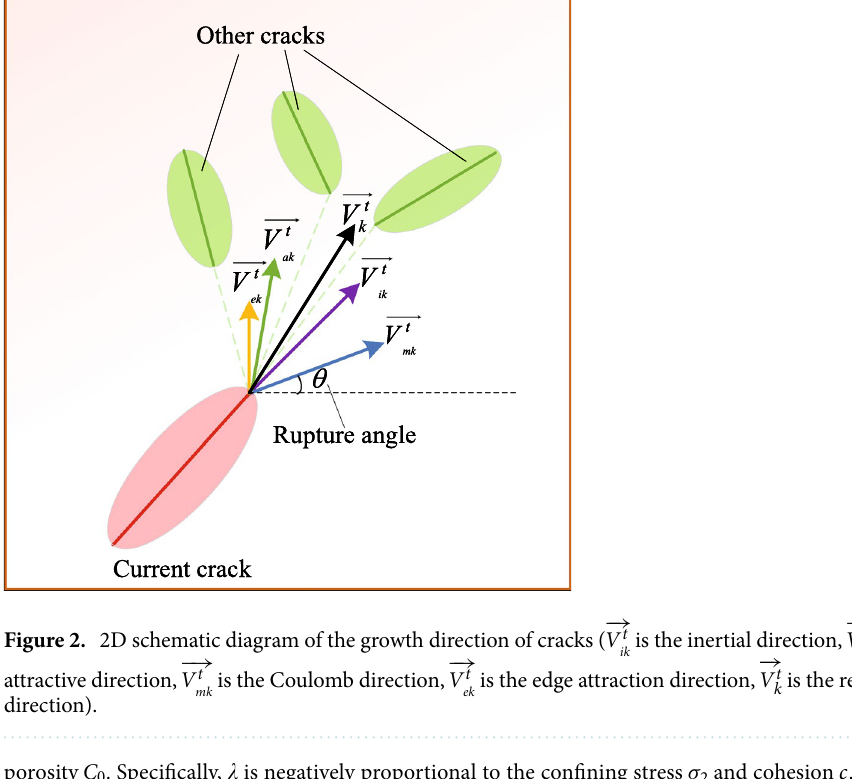
porosity C 0 . Specifically, (cid:31) is negatively proportional to the confining stress σ 2 and cohesion c . In other words, larger confining stress will lead to slower crack propagation, which accords with the laws of Eq. (10), indicat- ing that larger confining stress prolongs the time to reach the peak stress. Similarly, the cohesion c of the rock reveals the same pattern. Furthermore, increasing the loading rate or decreasing the initial porosity will promote the growth of cracks. It is worth noting that the initial porosity should not be greater than 0.5, otherwise the transformation rate will be negative (see Fig. 1). The effect of friction angle φ ( f = tan φ ) on the transformation rate (cid:31) is not obvious, but we can rewrite the right part of Eq. (11) as: